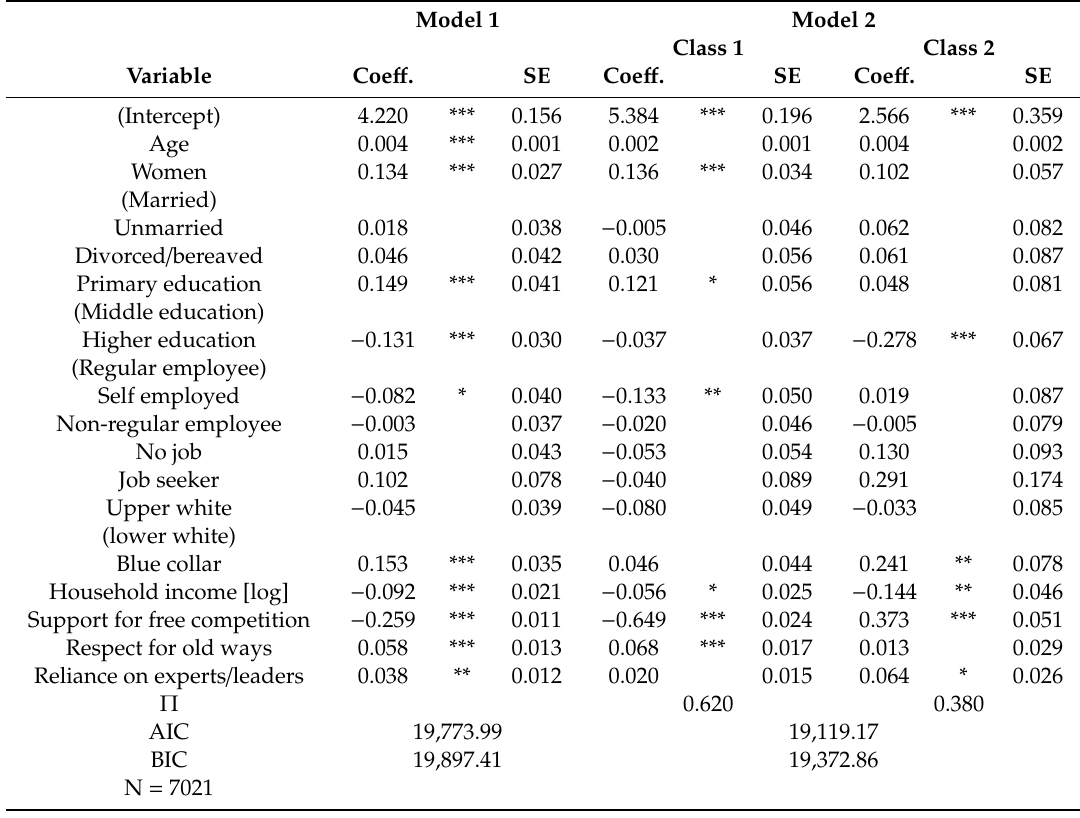
Table 2. Results for the finite mixtures of regression models predicting support for